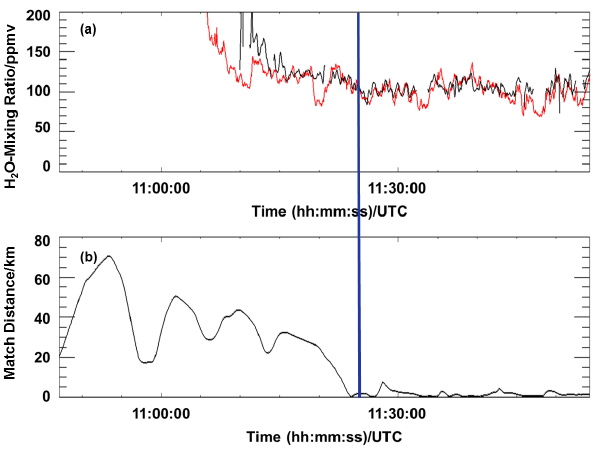
Figure 4. (a) Water vapour mixing ratio as retrieved by the WARAN instrument flown on the Falcon (red line) and the WALES instru- ment (black line) at the same altitude. (b) Horizontal distance be- tween the two aircraft as a function of time.